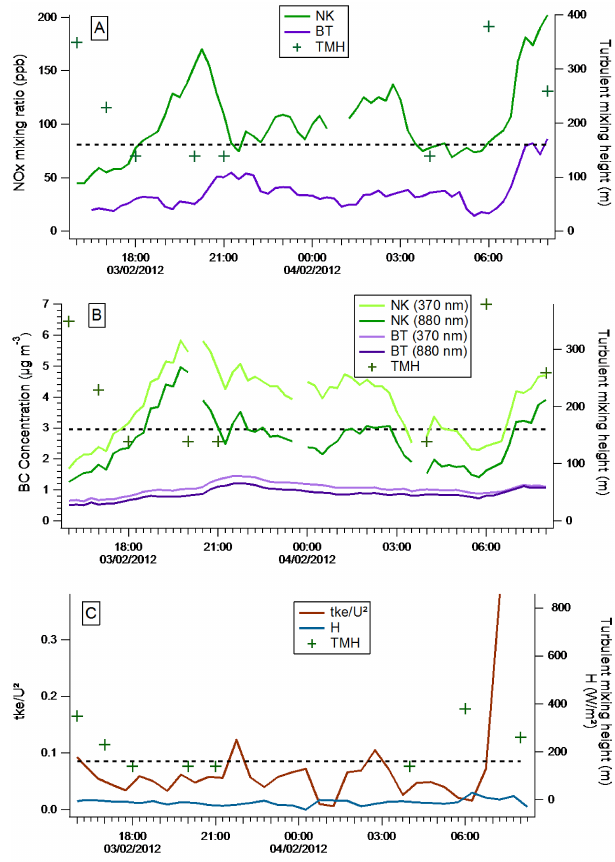
Figure 13. Time series of NO x concentration (a) and BC concen- tration measured at 370 and 880nm (b) during a de-coupling event as marked by the turbulent mixing heights (TMH). For times where there are no TMH data in the figure, this is due to the turbulent layer lying below the lowest range gate of the Doppler lidar i.e. minimum resolvable TMH is 139m. Also shown for this de-coupling event is the sensible heat flux ( H ) and turbulent kinetic energy normalised by the wind speed (tke/ U 2 ) as measured at the BT tower (c) . Note the dashed line represents the height of the T35 sampling level of the aethalometers